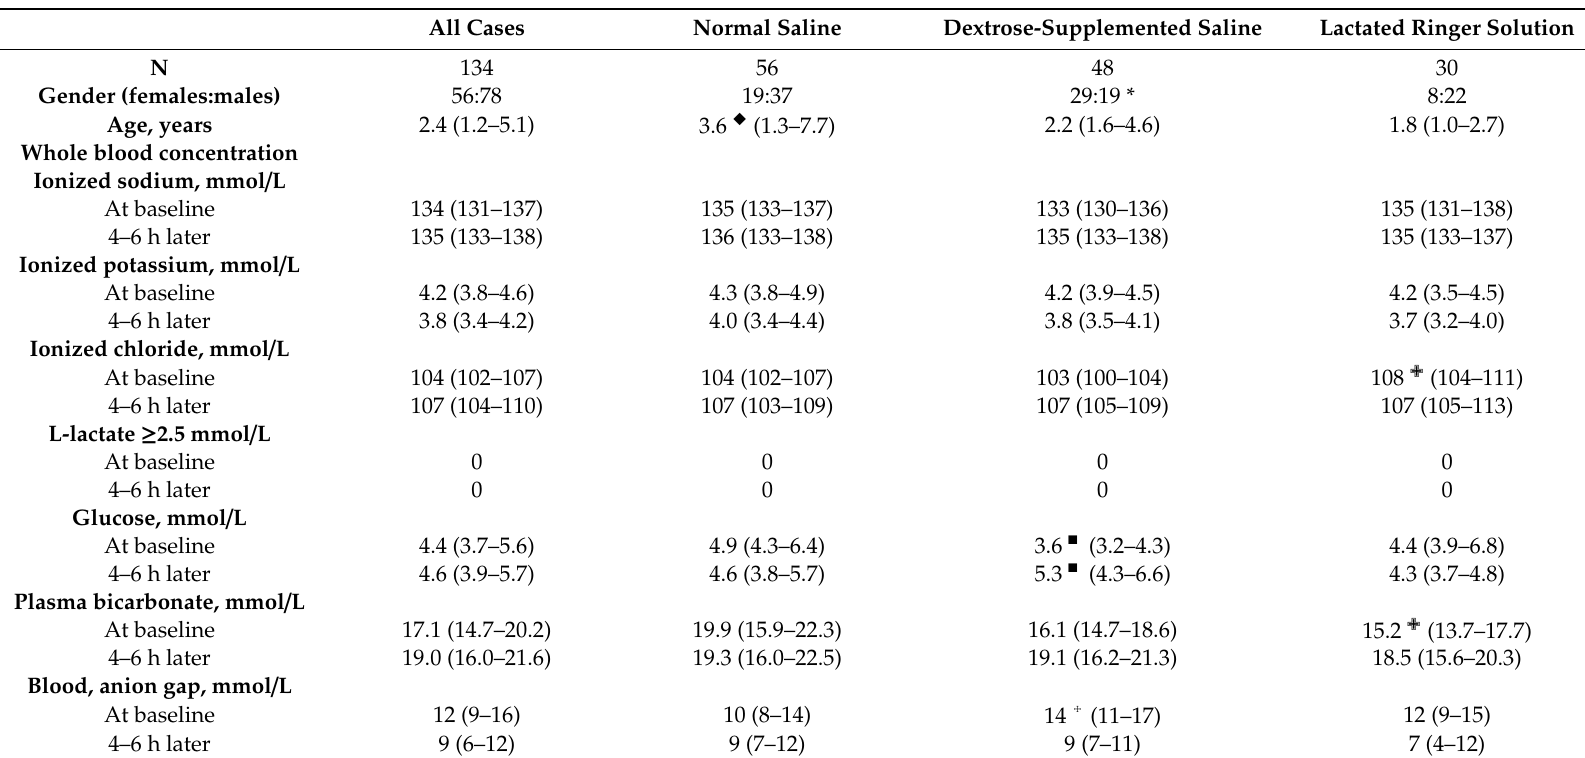
Table 1. Demographics and laboratory data of 134 children 5 months to 15 years of age affected by acute gastroenteritis presenting with mild to moderate dehydration and failure of oral rehydration. Laboratory values are given at baseline and 4–6 h after intravenous fluid therapy at a constant rate of 70 mL/m 2 body surface area per hour. Data are presented as frequency or as median and interquartile range.